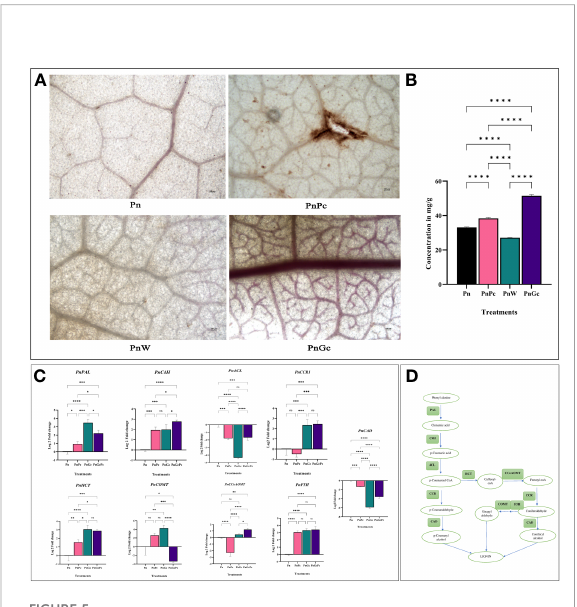
FIGURE 5 (A) Weisner staining to visualize lignin deposition after